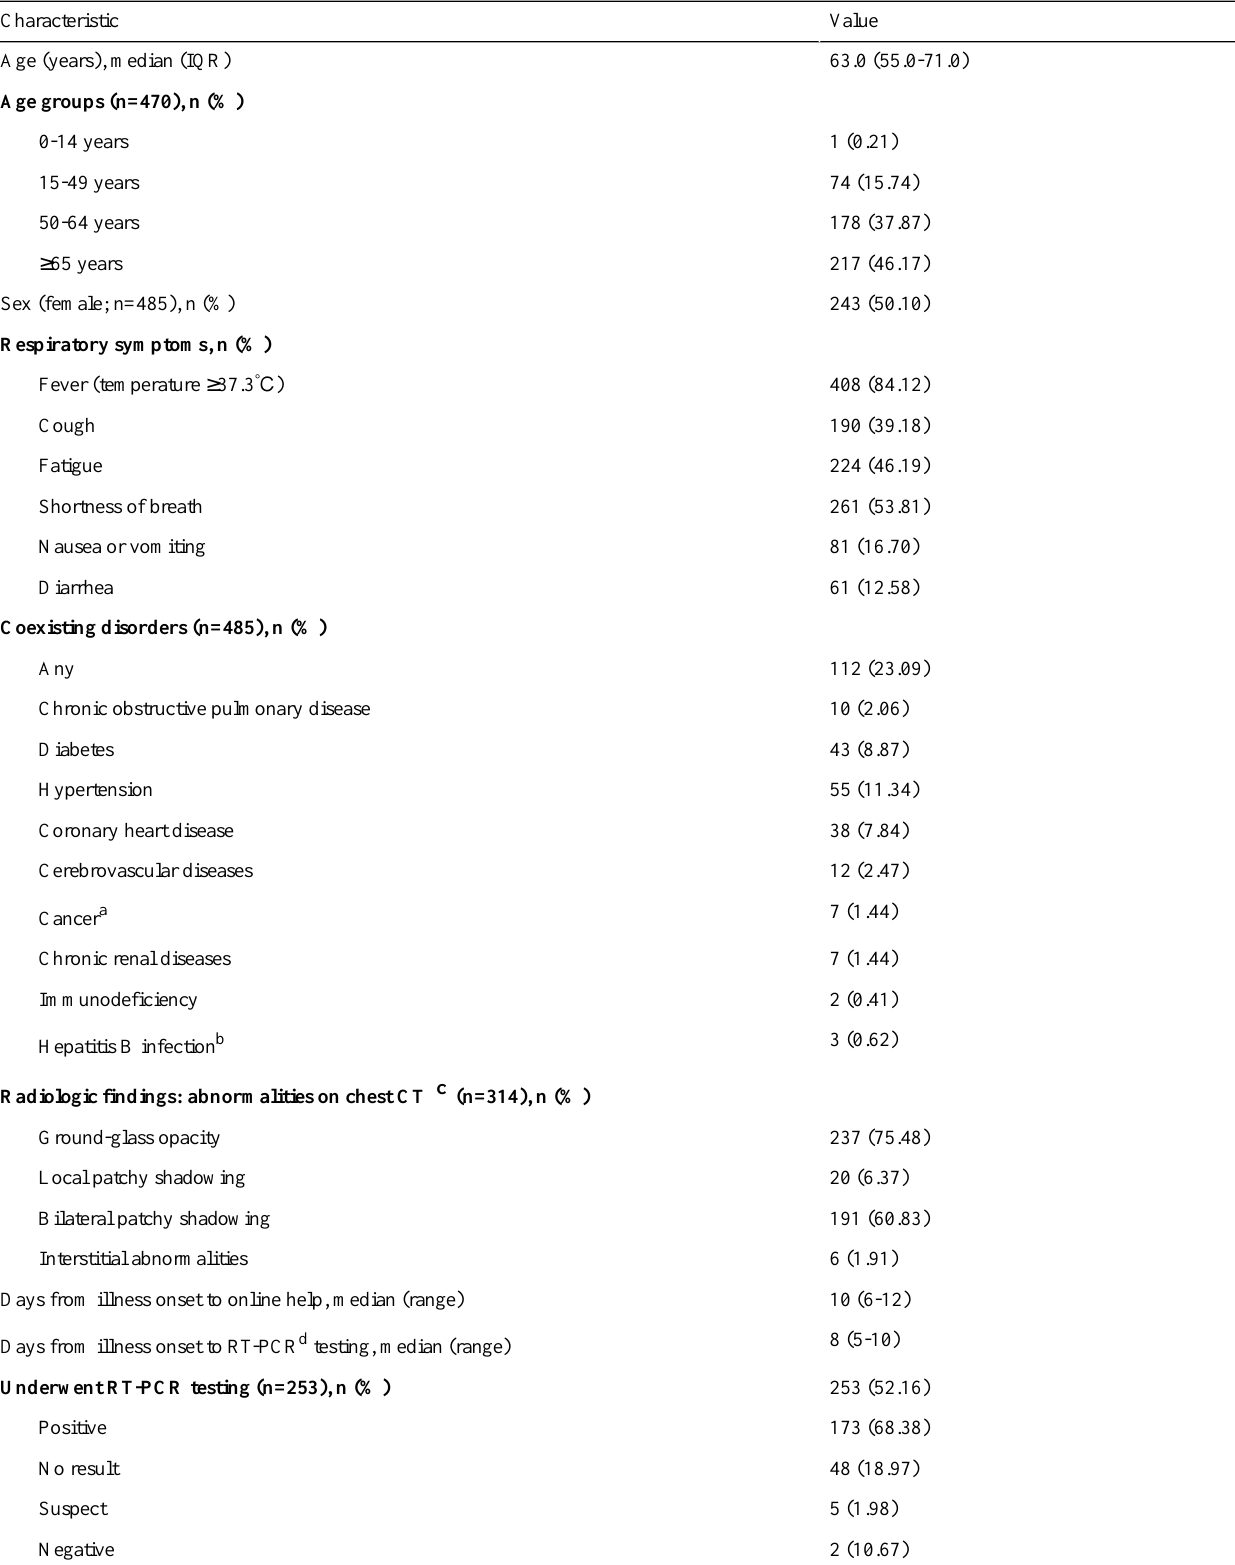
Table 1. Clinical characteristics of suspected or laboratory-confirmed patients with severe acute respiratory syndrome coronavirus 2 (SARS-CoV-2) infection